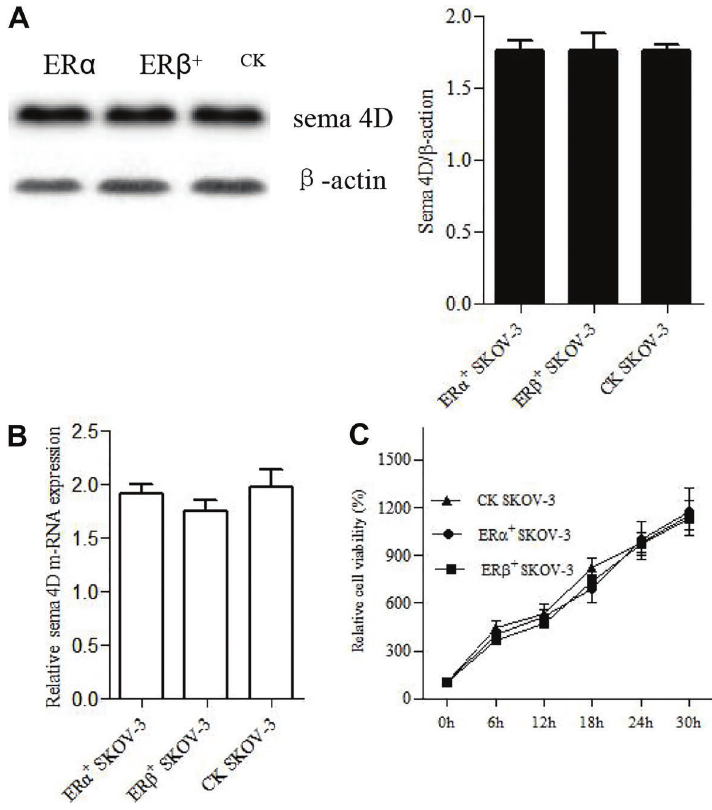
Figure 5. Effect of estrogen receptors (ERs) inhibitor ICI182-780 on semaphorin (sema) 4D expression and cell proliferation. A , sema 4D protein expression by western blotting; B , sema 4D m-RNA expression by RT PCR. b -actin was used as the internal standard; C , cell proliferation assay. Data are reported as means ± SD of relative viability of cells represented by the ratio of OD 450